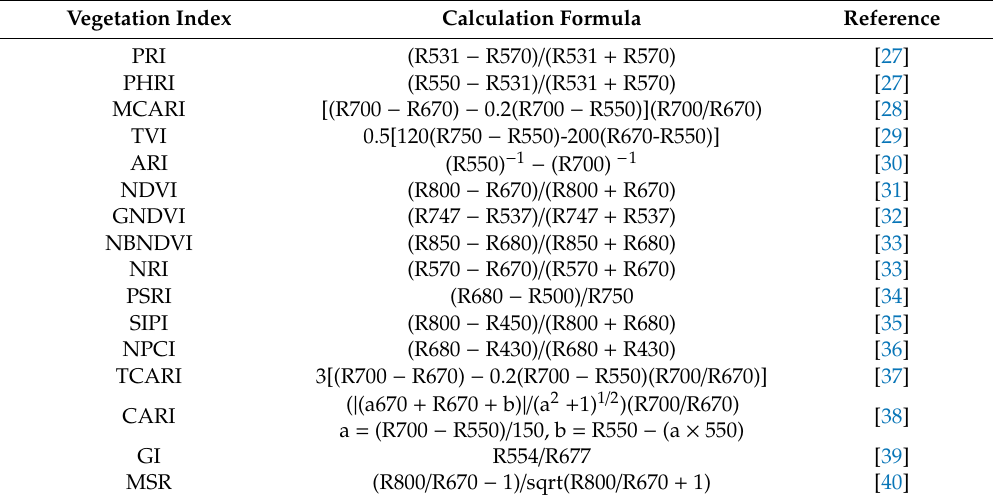
Table 4. Vegetation indices commonly used in stress